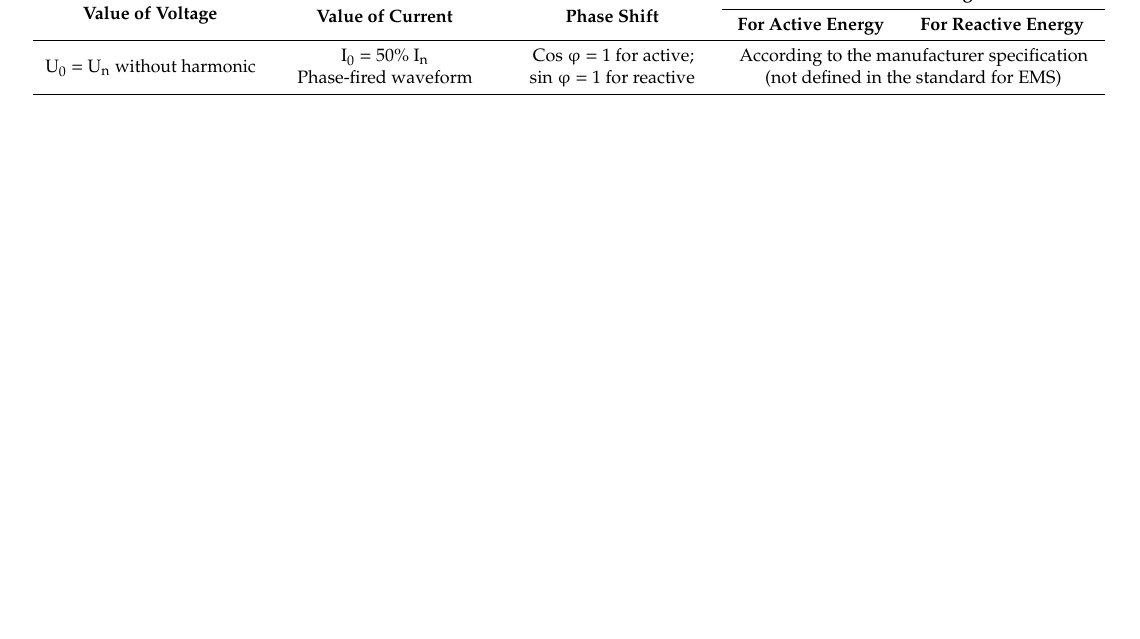
Additional Percentage Error For Active